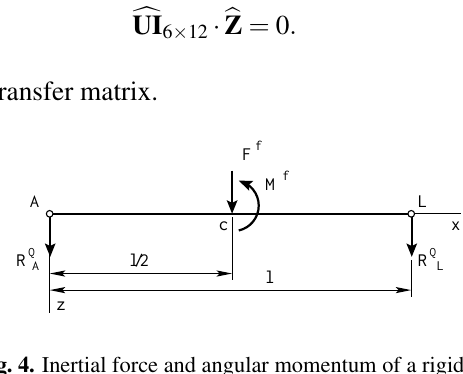
Fig. 4. Inertial force and angular momentum of a rigid